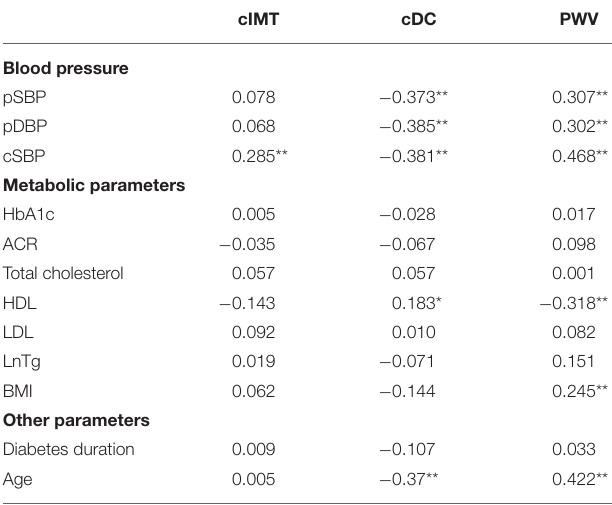
cSBP were positively associated with PWV (for pSBP r = 0.307, for pDBP r = 0.302, for cSBP r = 0.468; p ≤ 0.001 for all) and